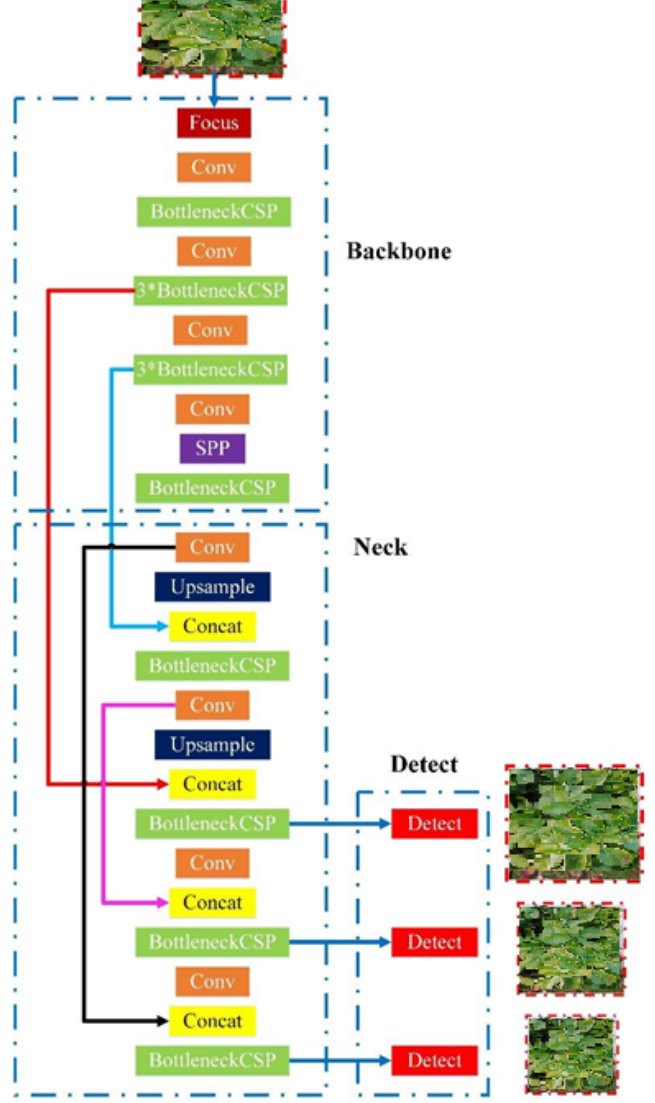
Figure 4. YOLOv5s model